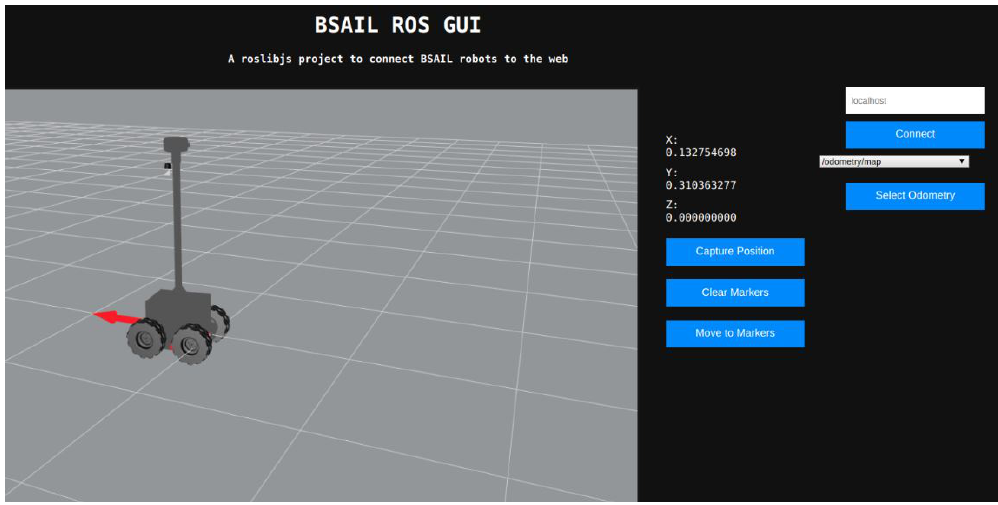
Figure 5. Graphic User Interface (GUI) for MARIA.